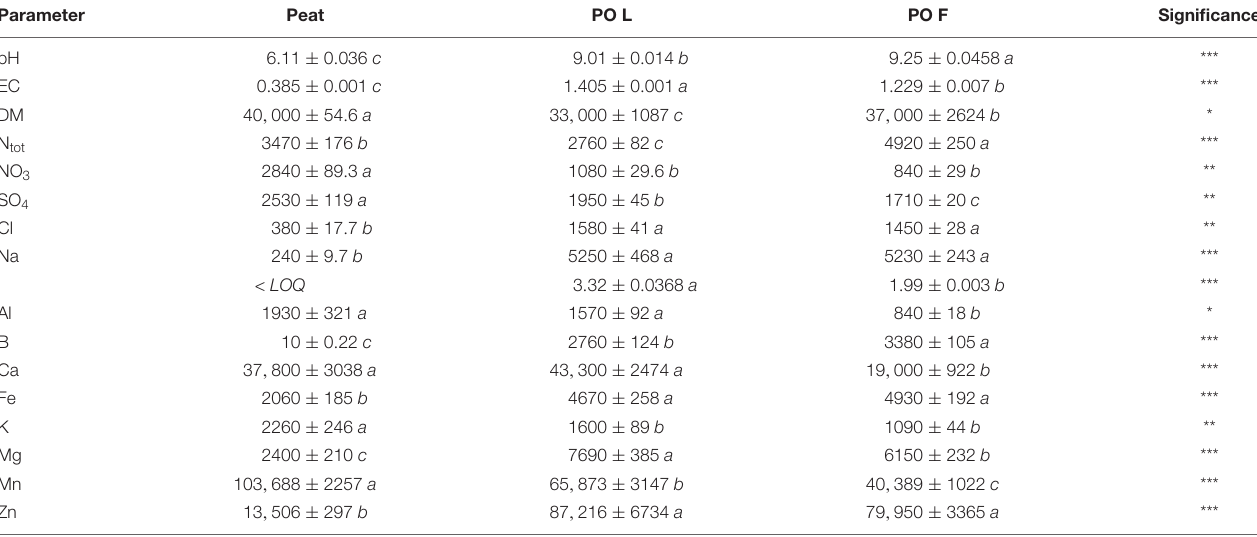
TABLE 1 | pH, EC (mS/cm), dry matter (DW, mg/100 g FW) and elemental composition (mg/kg DW) of Posidonia oceanica (L.) Delile leaves (PO L) and fibers (PO F). Parameter Peat PO